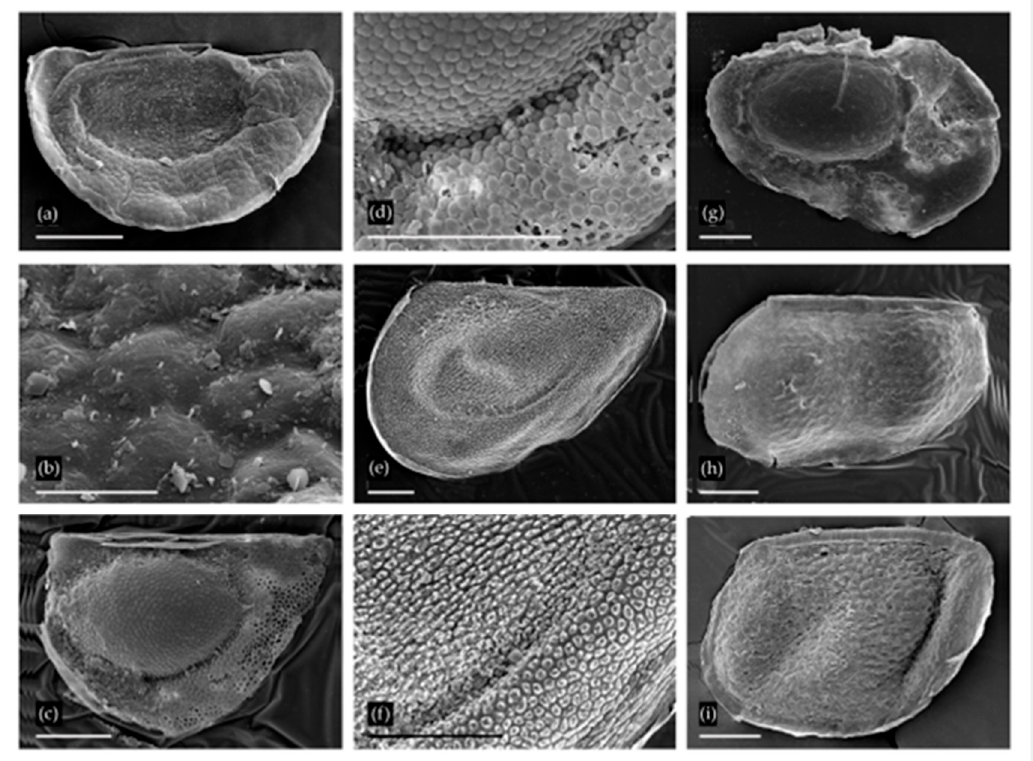
Figure 3. Ephippia of Daphniidae and Moinidae from two localities: ( a , b ) Ceriodaphnia pulchella - reticulata from Utruy, general view and sculpture in the region of egg locula; ( c , d ) Ceriodaphnia laticaudata from Urtuy, general view and sculpture at margin of egg locula; ( e , f ) Simocephalus sp. from Urtuy, general view and sculpture of ephippium; ( g ) Moina brachiata from Nozhiy; ( h ) Moina macrocopa group from Nozhiy; ( i ) Moina macrocopa group from Urtuy. Scale bars: 0.1 mm for a, c–i; 0.01 mm for b.